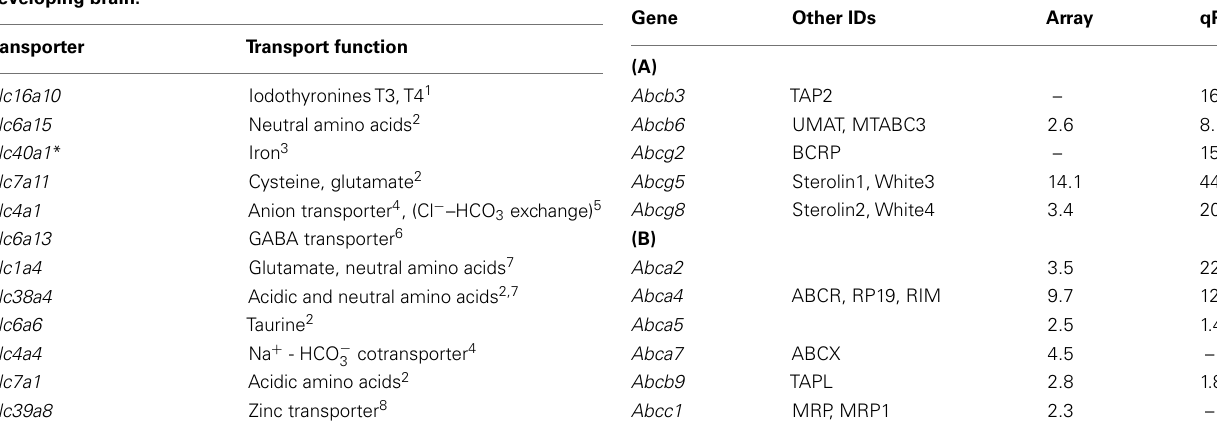
Table 4 | Comparison of expression of influx transporters in mouse E15 choroid plexus and published reports on transport function in the developing brain.